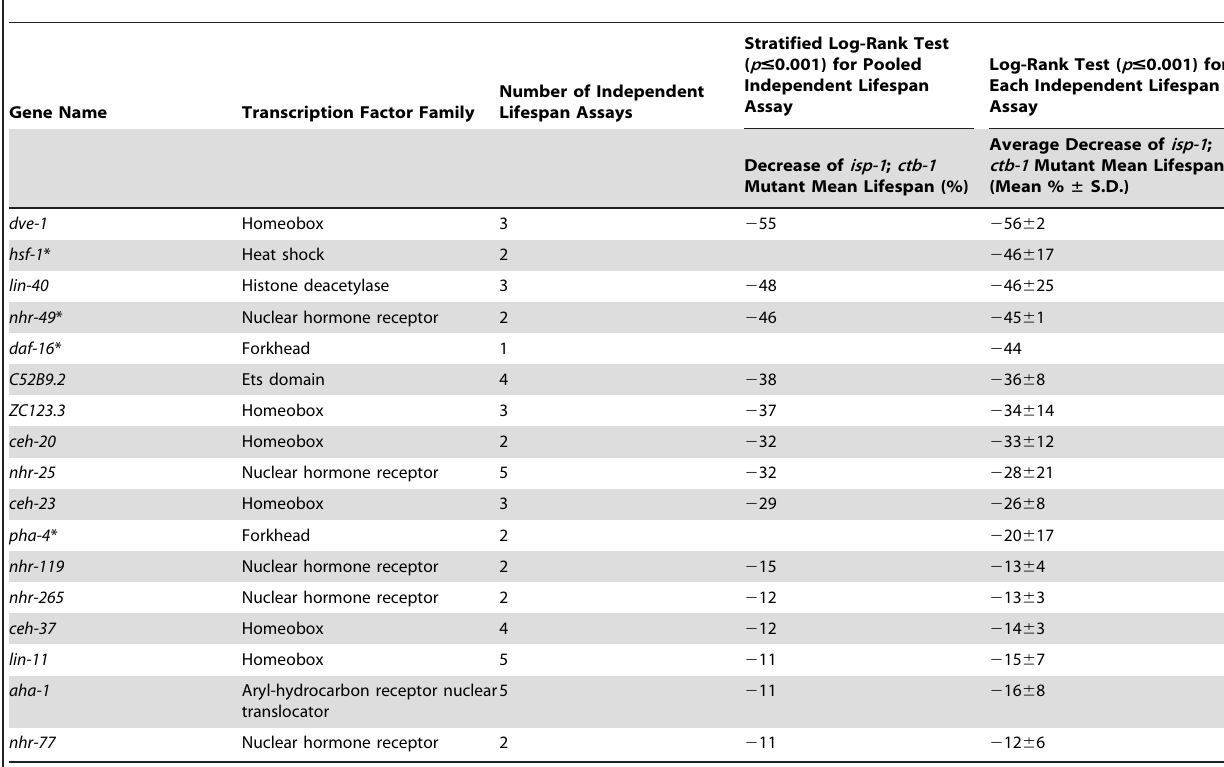
Table 1. A targeted RNAi screen identifies 17 RNAi candidates that decrease the prolonged lifespan of the METC mutant isp-1;ctb-1 by at least